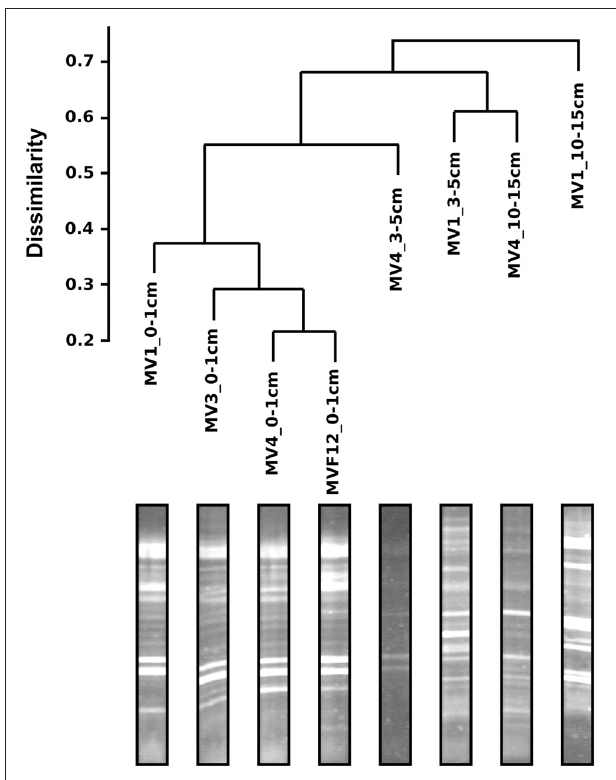
FIGURE 3 | Bacterial DGGE gel profile and cluster analysis of the resulting diversity. Scale represents distance computed as Jaccard dissimilarity on the presence/absence matrix.